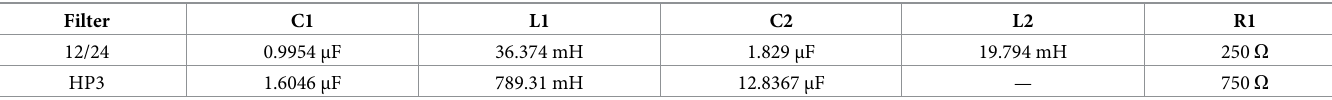
Table 11. Rated element parameters of the two